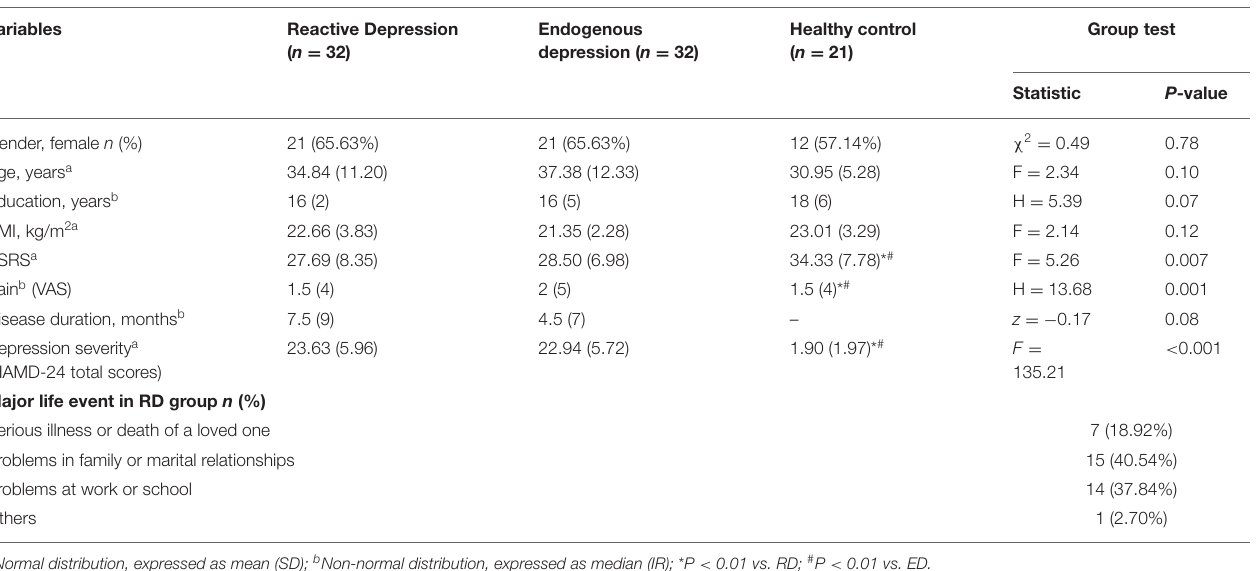
TABLE 1 | Demographic and clinical characteristics of participants.